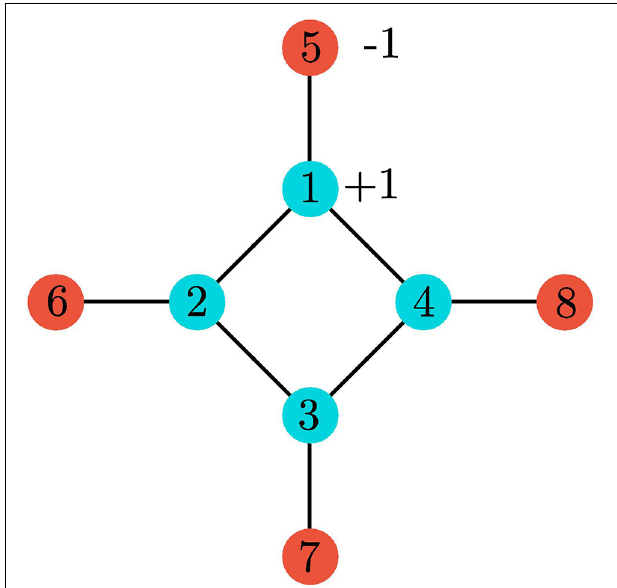
FIGURE 1 | The eight spin graph from Boixo et al. [1]. Each spin is coupled to its neighbors along the graph with a + 1 coupling such that the spins like to be aligned. In addition, the inner “core” spins have a magnetic field applied in the + z direction while the outer “ancilla” spins have a field applied in the − z